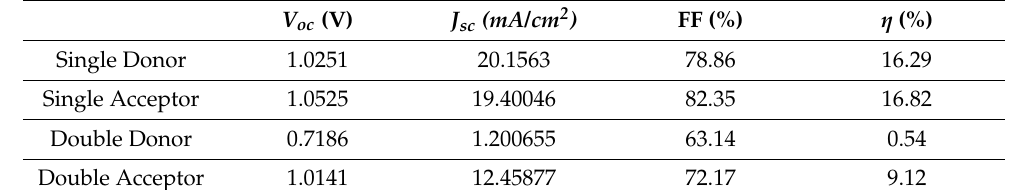
Table 5. Double donor defect state effect on output characteristics of solar cell.